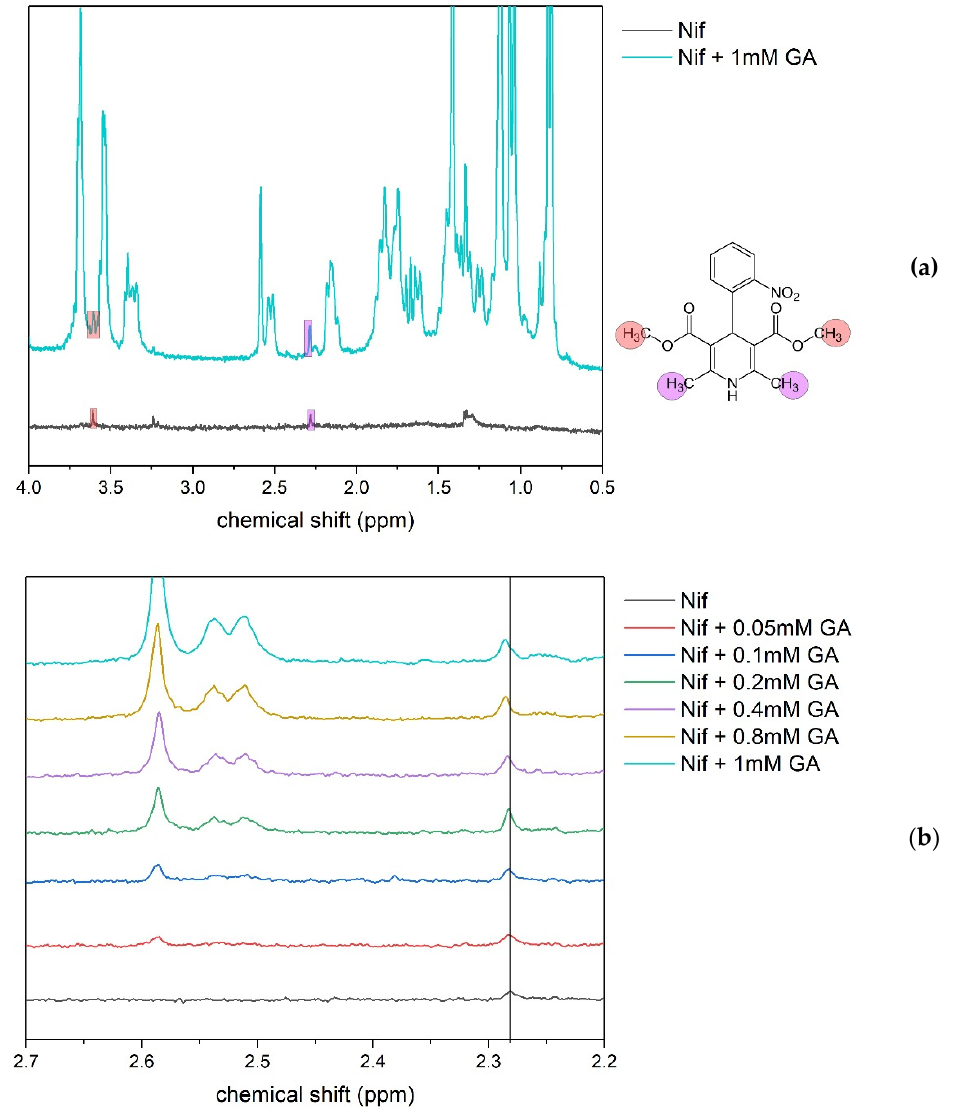
Figure 5. Fragments of 1H NMR spectra of mixtures nifedipine + GA at pH 6 ( a , b ). The assignment of nifedipine signals is taken from [38].